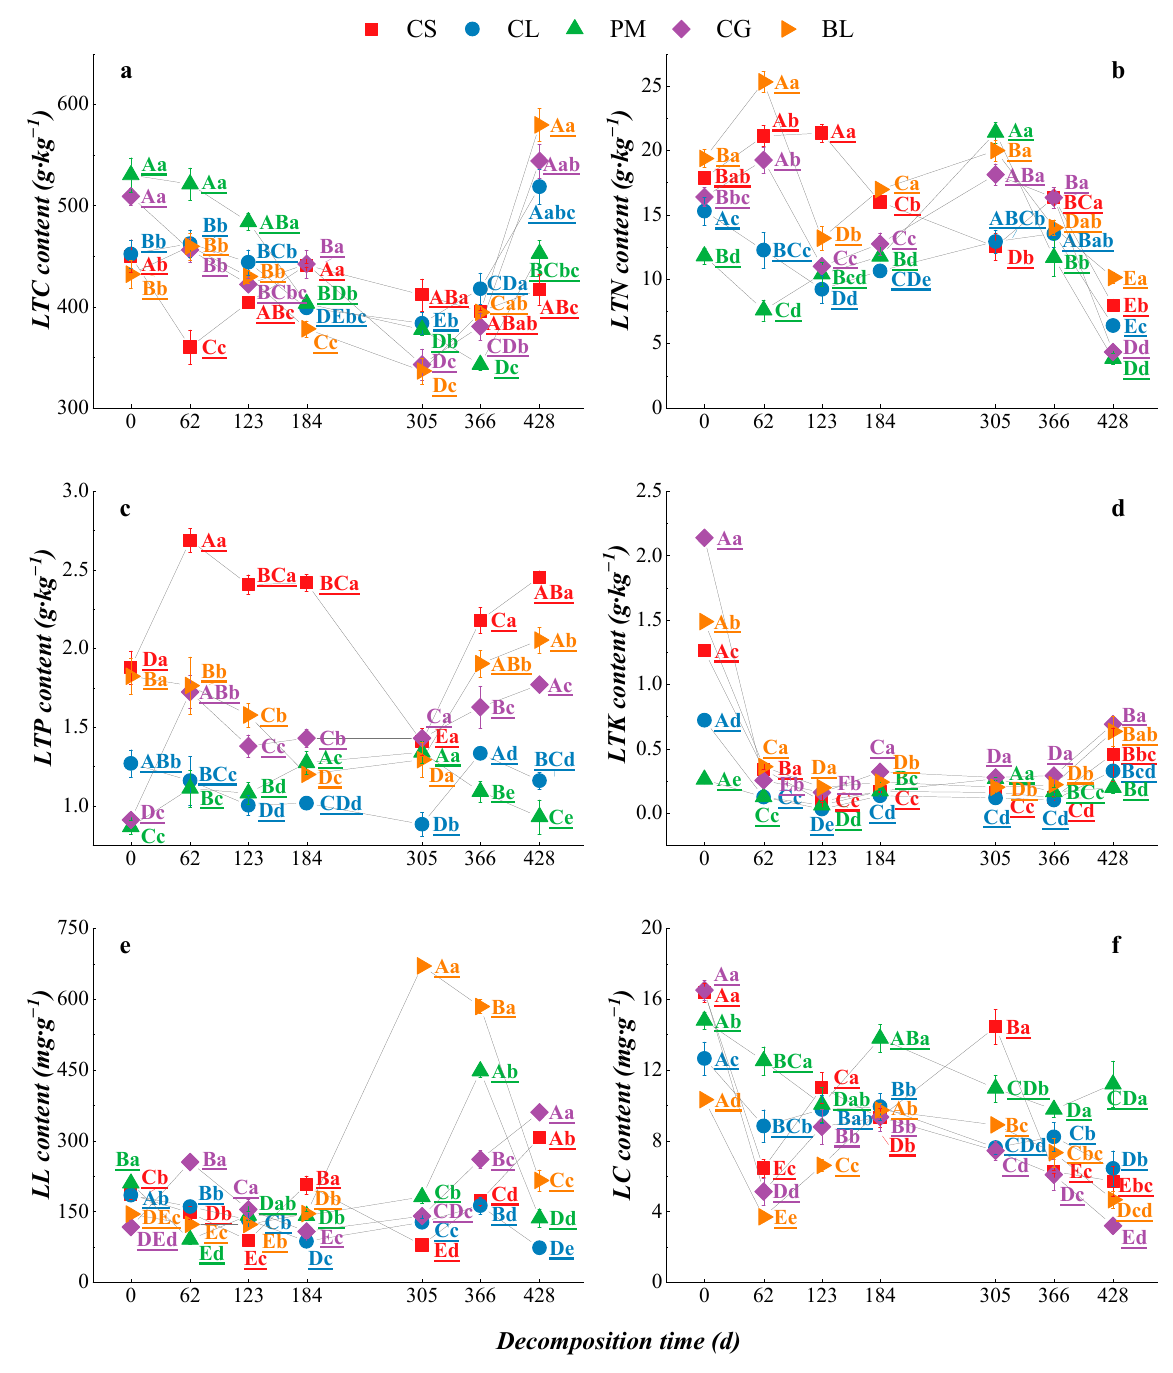
Figure 4. Dynamics of nutrient content in different litters during the litter decomposition process.